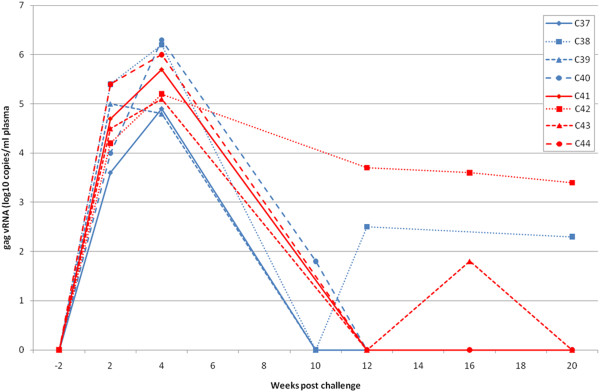
Viral RNA levels in macaques given immune serum (C37-40; group E: blue lines) and contemporaneous controls (C41-44; group F: red lines) after challenge with 50MID50SHIVsbgand followed for twenty weeks.